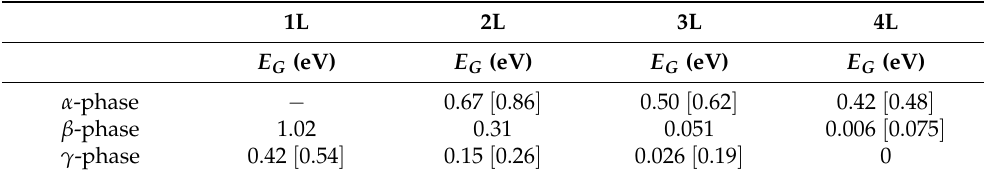
Table 2. Calculated DFT electronic bandgaps, for increasing number of layers and with the inclusion of SOC, of the three studied phases. When the bandgap is indirect, we also report the direct bandgap value (in square brackets). Note that ML α -Te is unstable and 4L γ -Te is metallic. 1L 2L 3L 4L E G (eV) E G (eV) E G (eV) E G (eV) α -phase − 0.67 [ 0.86 ] 0.50 [ 0.62 ] 0.42 [ 0.48 ] β -phase 1.02 0.31 0.051 0.006 [ 0.075 ] γ -phase 0.42 [ 0.54 ] 0.15 [ 0.26 ] 0.026 [ 0.19 ] 0 In the case of the β -phase, bandstructure calculations were performed along the high- symmetry directions given by the k-path Y → Γ → X → S → Y in the orthorhombic 2D Brillouin Zone (BZ) (Figures 3 and 4). Interestingly, in ML β -Te (as well as in 2L and 3L) the inclusion of SOC induces a transformation from an indirect to a direct bandgap at the Γ point, in agreement with Zhu et al. [14]. By increasing the number of layers, the electronic bandgap of the β -phase decreases from 1.02 eV (in agreement with Refs. [14,46]), in the ML case, to 0.31 eV (2L), 51 meV (3L) and 6 meV (4L), in which the valence band maximum (VBM) and the conduction band minimum (CBM) move away from the Γ point, giving rise to an indirect bandgap.